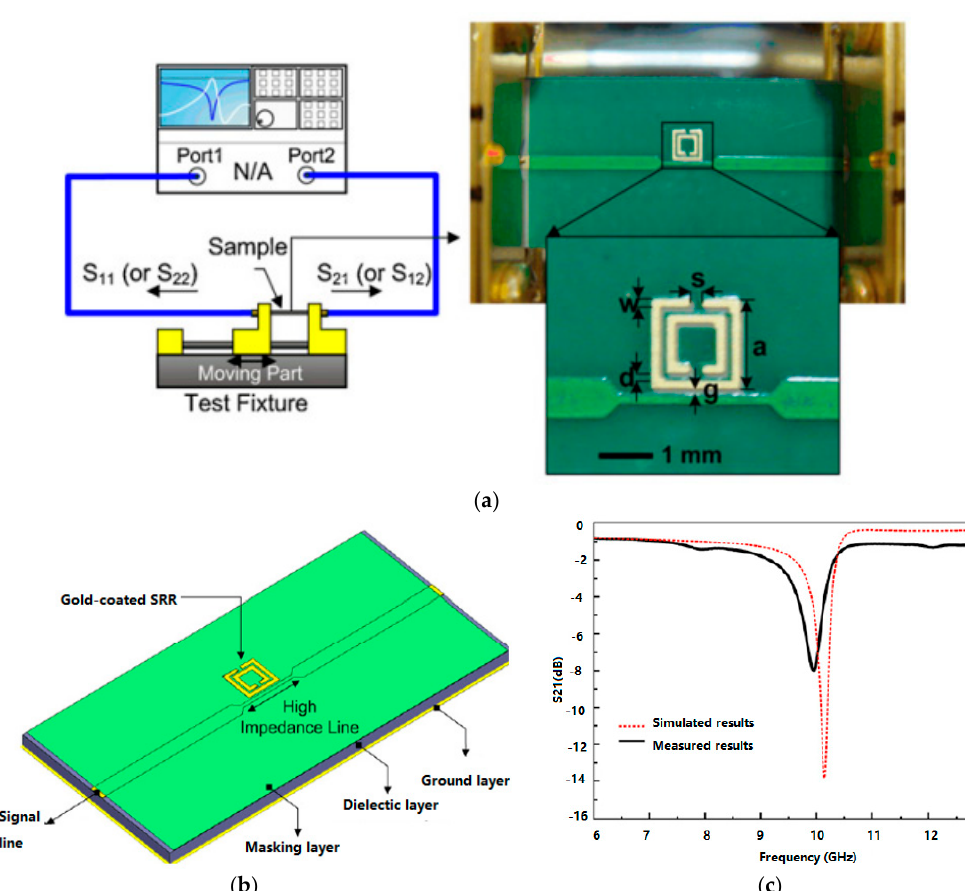
Figure 5. ( a ) RF measurement setup of the SRR-based RF biosensor; ( b ) schematic of the SRR-based RF biosensor; ( c ) simulated and measured results of the SRR-based RF biosensor. S11 denotes the reflection and S21 means transmission coefficient.